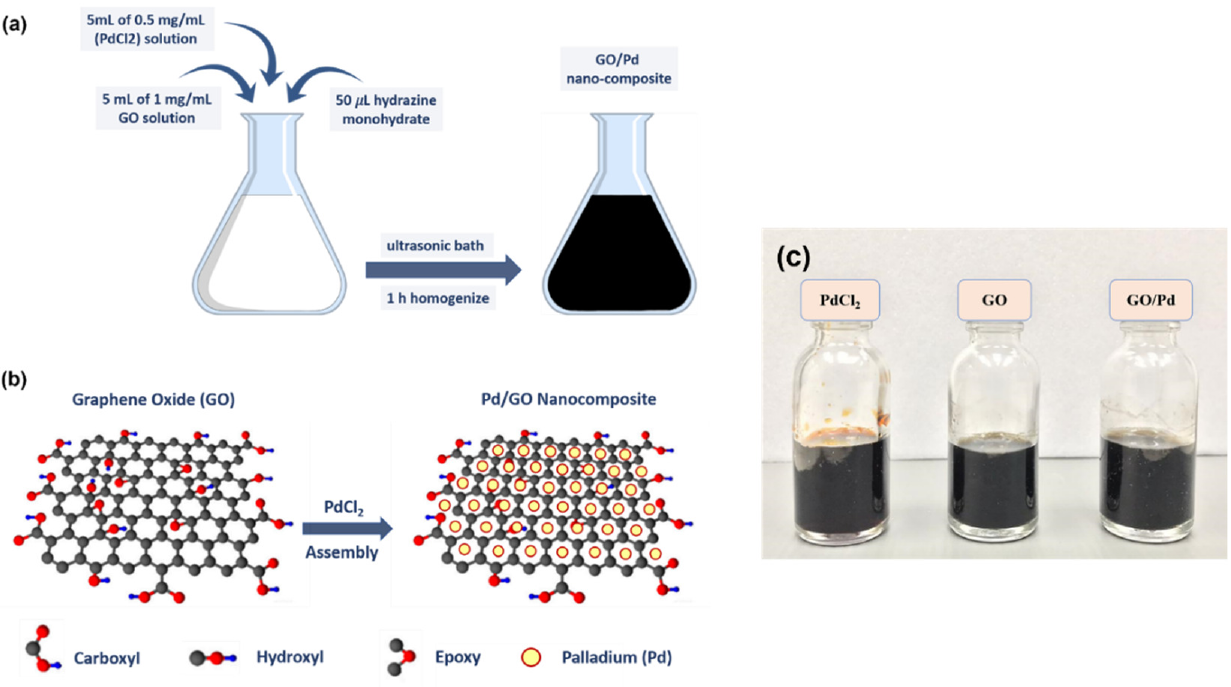
Figure 4. ( a ) Synthesis process of Pd/GO nanocomposite, ( b ) Schematic view of the Pd/GO nanocomposite setting, and ( c ) The stable solution of PdCl 2 , GO, and Pd/GO nanocomposite.